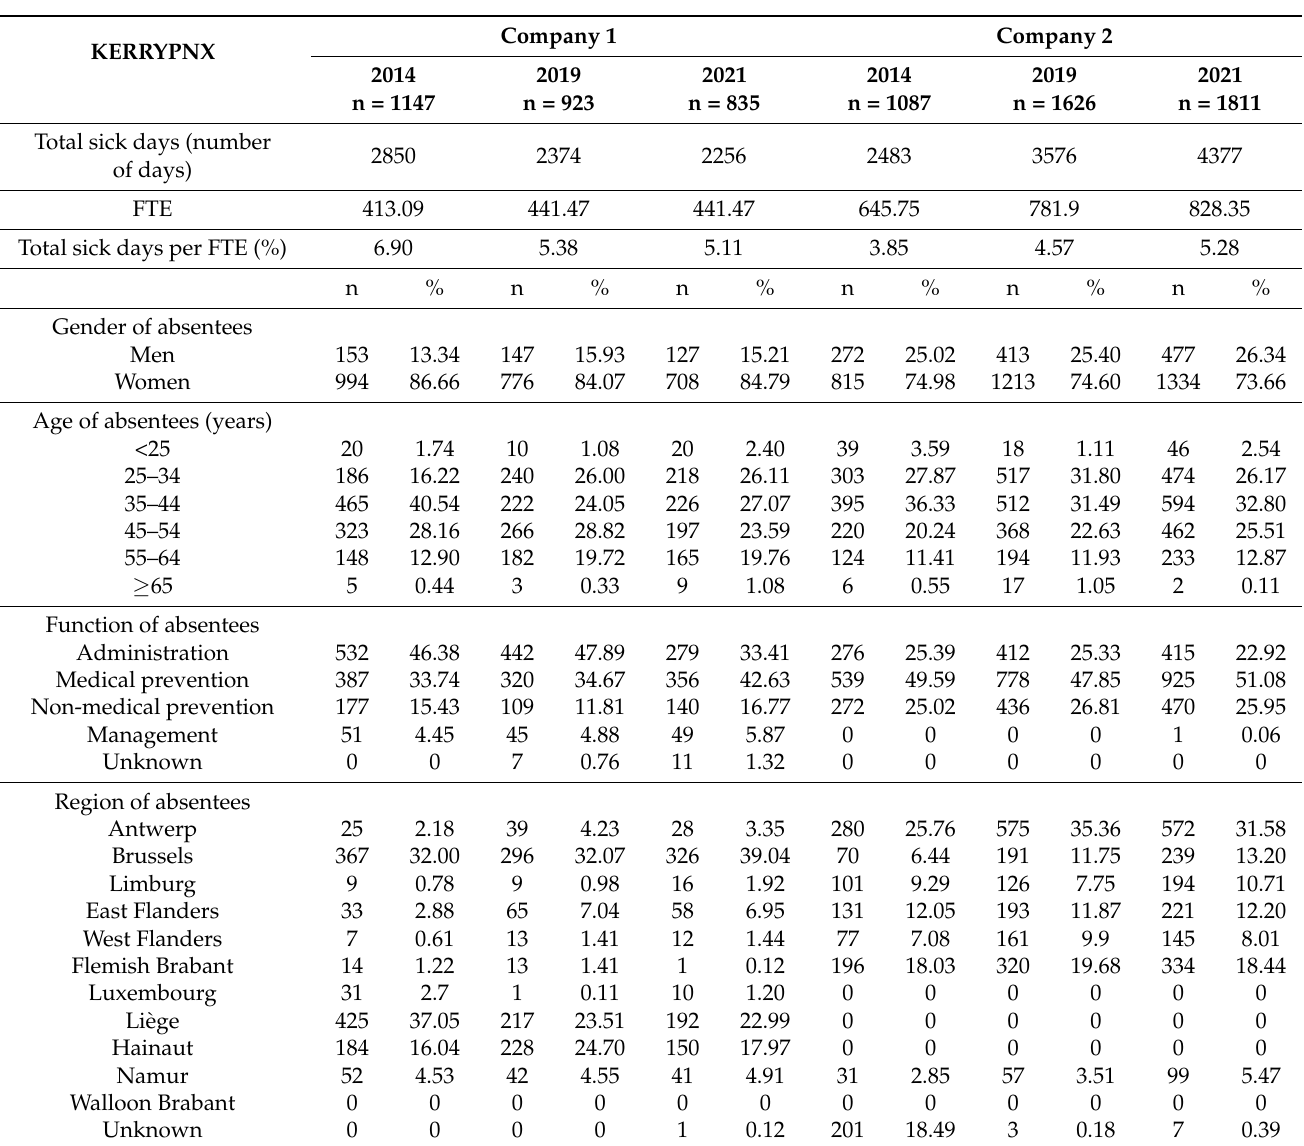
Table 1. Characteristics of absenteeism data from two occupational health services in Belgium in 2014, 2019, and 2021. The table shows the absolute numbers and percentages of absentees in the two companies categorized by gender, age, function, and